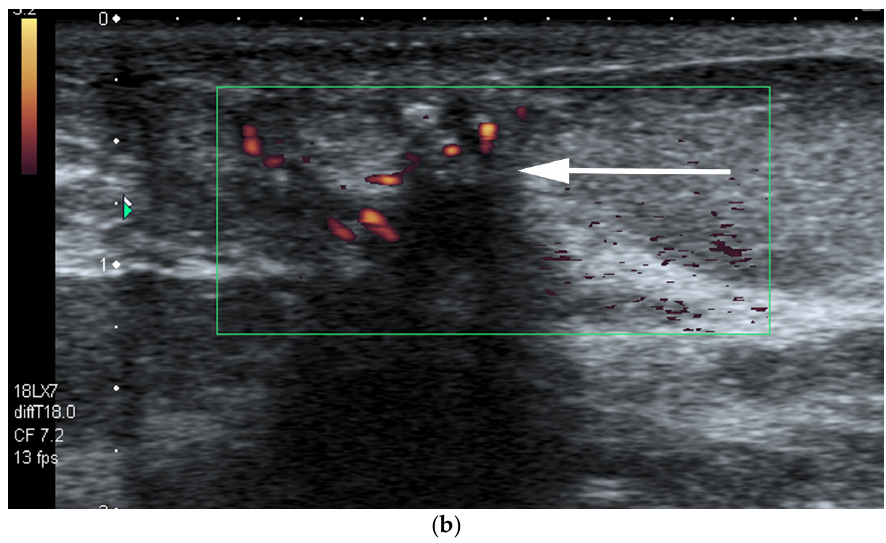
Figure 14. 70 year-old patient referred for abnormal screening mammograms. Left CC magnification view demonstrates linear pleomorphic calcifications in a retroareolar location. US images shows microcalcifications are located within a dilated duct and associated with a rim vascularity at color Doppler interrogation ( b ) (arrow).